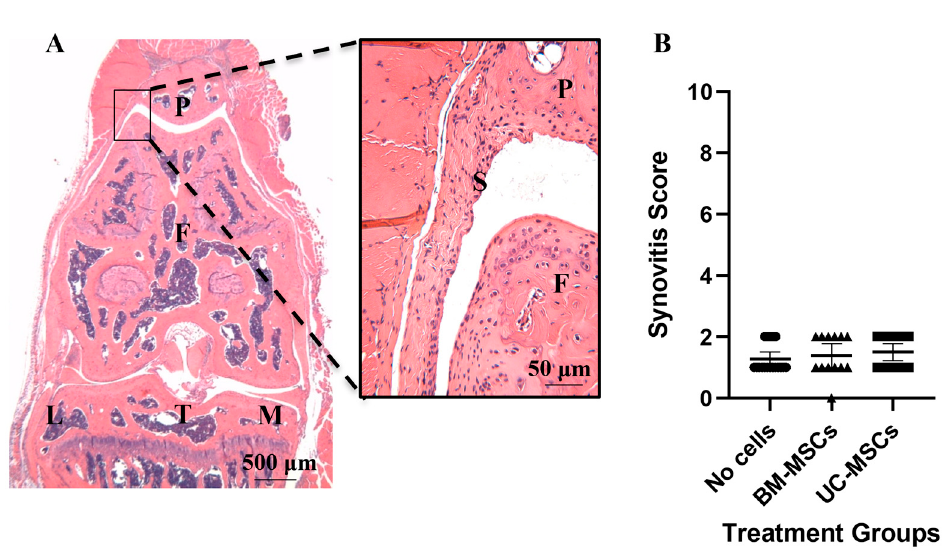
Figure 3. Assessment of synovial reaction to the JSI following treatment. A representative H&E stained section of ( A ) a murine knee joint 8 weeks post-injury from a mouse that received hUC-MSCs. The boxed region, where synovitis was scored, is also shown at a higher magnification. Synovitis was assessed using a 10-point system (0 being normal to 10 being severely inflamed). Synovium, S; patella, P; femur, F; tibia, T; lateral side, L; medial side, M. ( B ) Synovial reaction was not significantly different between any of the treatment groups. Data are presented as the mean ± 95% CI.